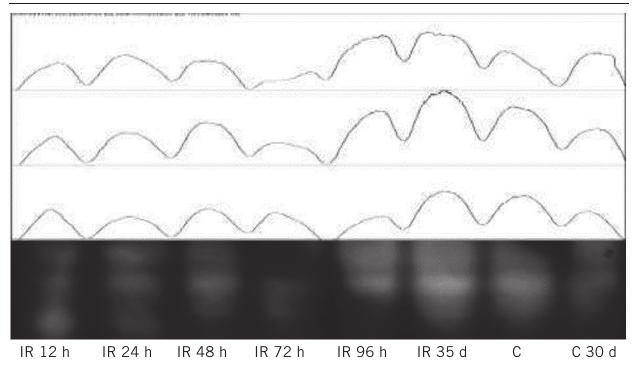
figurE 4 − Electrophoretic profile of SG3 proteins after whole-body exposure to 5 Gy SG3: subgroup 3.